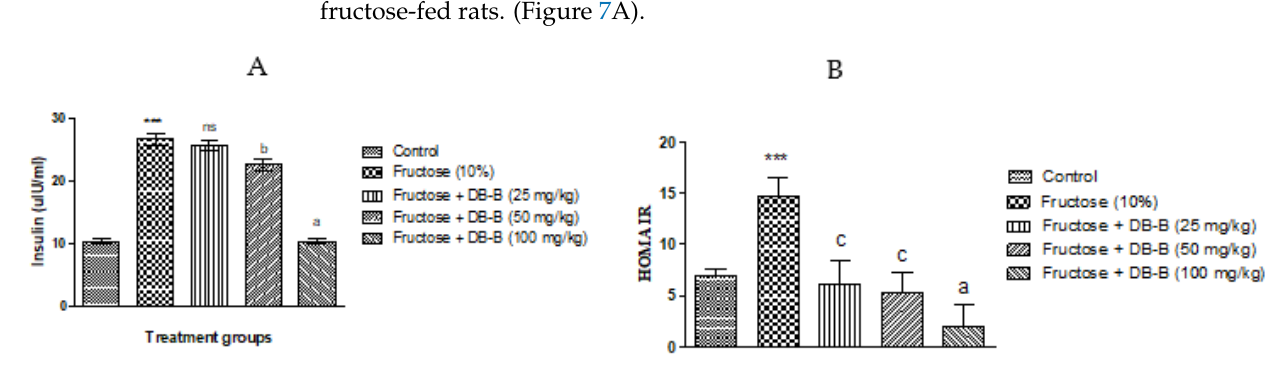
Figure 7. DB-B caused a decrease in serum insulin and HOMA-IR in fructose-fed rats: ( A ) decrease in serum insulin, and ( B ) HOMA-IR. Results were analyzed statistically using one-way ANOVA followed by the Bonferrani test. Results are plotted as mean ± SEM (n = 5) where a = p < 0.001 and b = p < 0.01, c = p < 0.05, and ns = non-significant when compared with fructose (10%), whereas *** = p < 0.001 compared with the control.